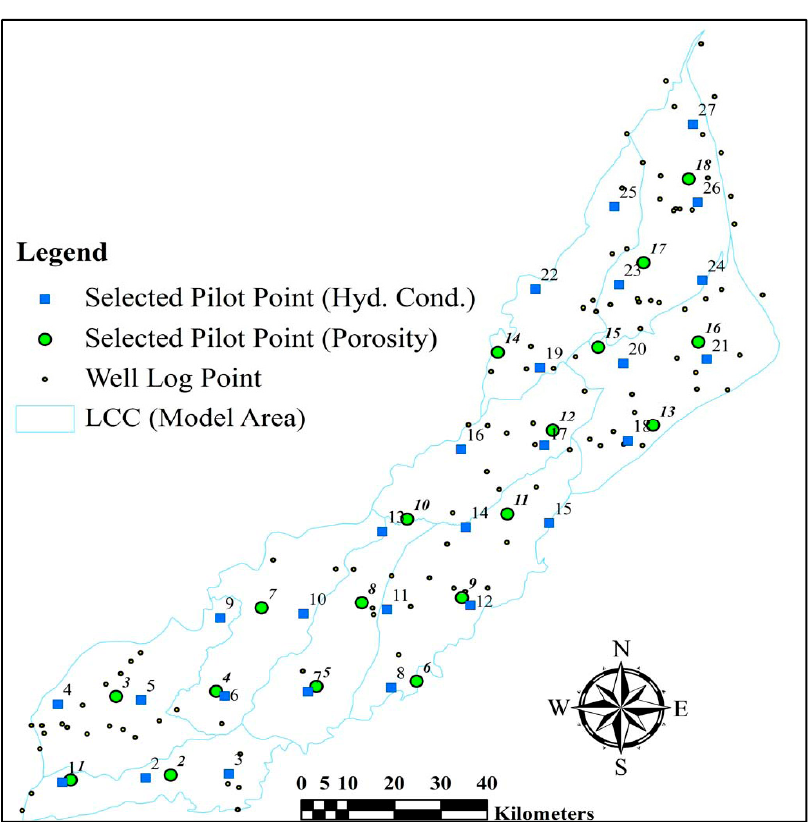
Figure 5. Location of selected pilot points at different locations of LCC. Please note different locations of pilot points for hydraulic conductivity and effective porosity in a given layer but similar for each model layer.